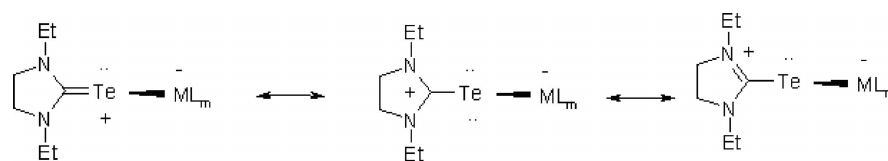
Figure 1 The molecular structure of the title compound (I) with the atom numbering scheme. Displacement ellipsoids for non-H atoms are drawn at the 30% probability level. [Symmetry code: ( a ) - y + 1, - x + 1, - z + 3/2.]